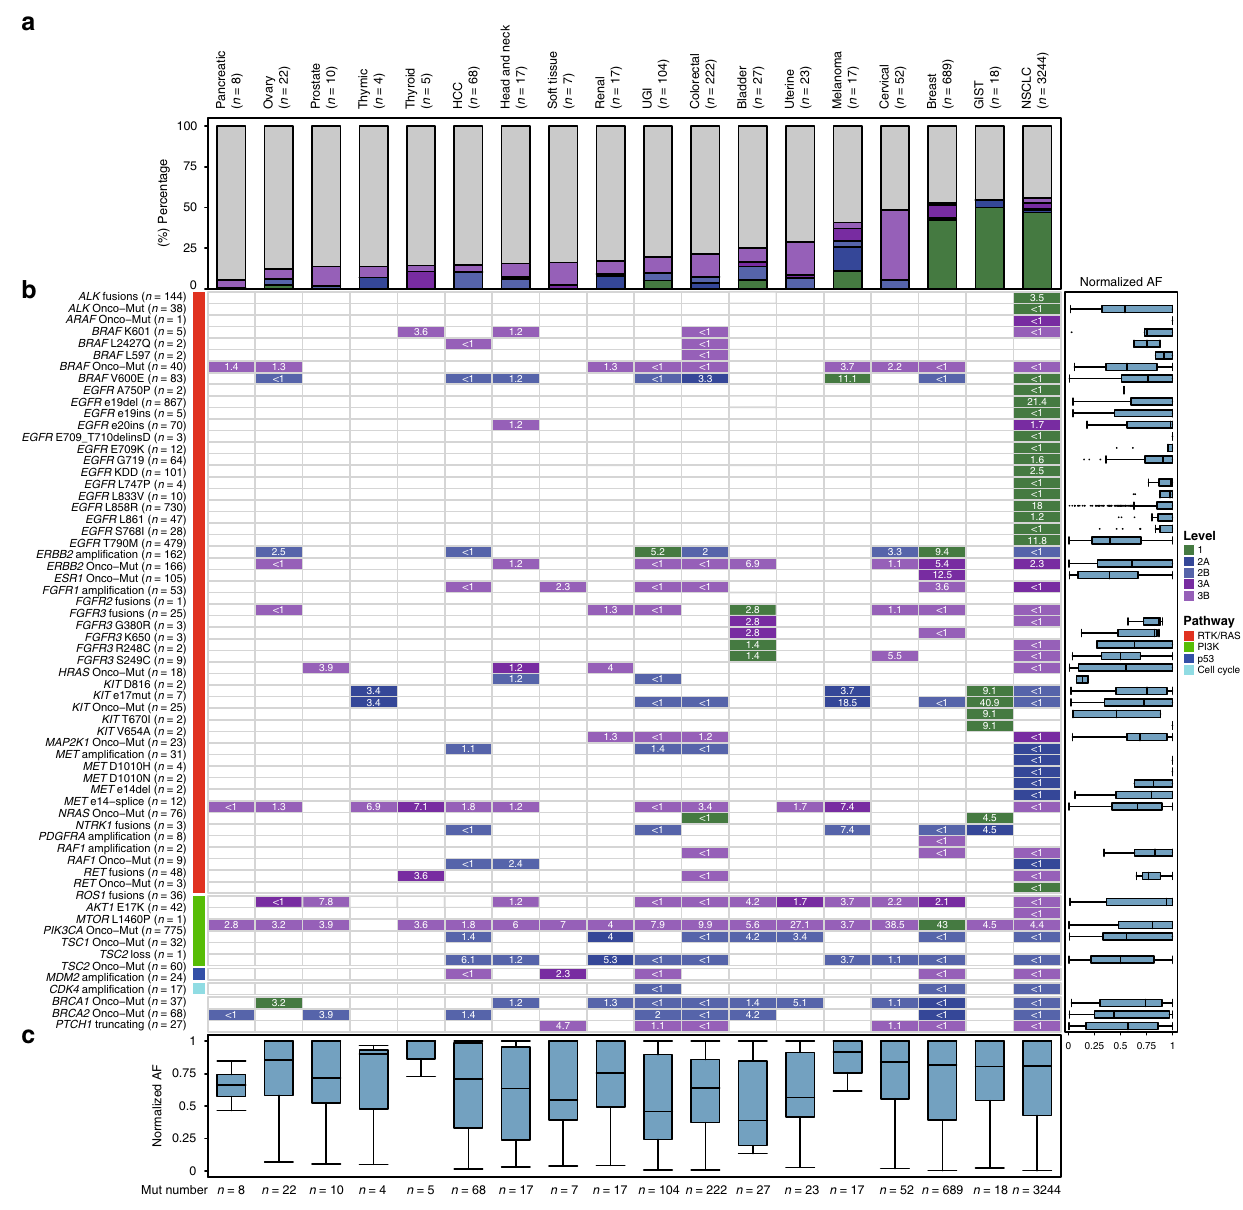
Fig. 6 Overview of therapeutic actionability revealed by ctDNA pro fi ling. a Frequencies of clinical actionability across different cancer types, broken down by evidence levels. GIST gastrointestinal stromal tumor, HCC hepatocellular carcinoma, NSCLC non-small cell lung cancer, SCLC small cell lung cancer, UGI upper gastrointestinal cancer. b Frequencies of actionable alterations across cancer types. Alterations are grouped by pathway. The right box chart indicates the clonality distribution of different actionable alterations. Centre line, median; box limits, upper and lower quartiles; whiskers, 1.5× interquartile range; points, outliers. c Clonality distribution of actionable alterations in different cancer types. Centre line, median; box limits, upper and lower quartiles; whiskers, data